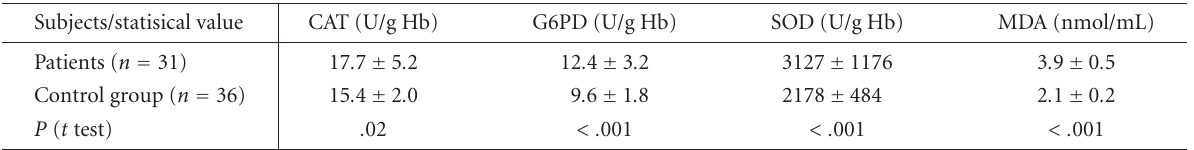
Table 1. The mean values of catalase (CAT), glucose-6-phosphate dehydrogenase (G6PD), and superoxide dismutase (SOD) activities and malondialdehyde (MDA) levels in patients and control groups (mean ± standard deviation). Subjects/statisical